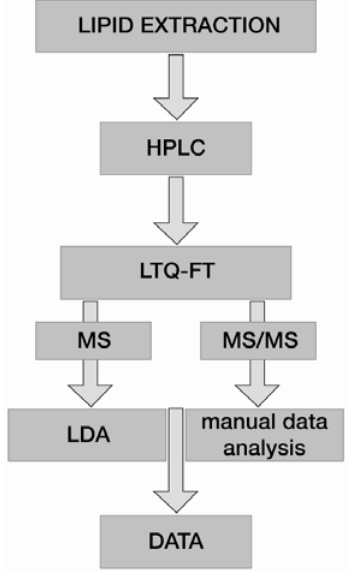
Figure 3. Workflow of a high resolution LC-MS platform relying on an LTQ-FT mass spectrometer. Full scan MS and MS/MS data are acquired parallel in data dependent acquisition mode. Full scan MS data are automatically processed and quantified by Lipid Data Analyzer (LDA), whereas MS/MS data are manually inspected for fatty acid